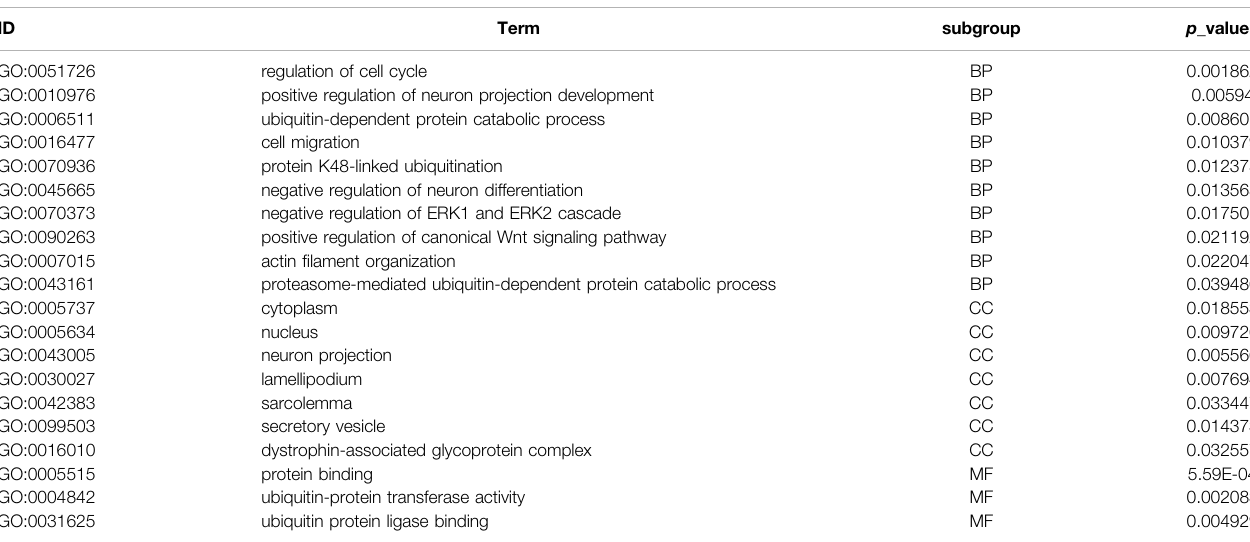
TABLE 5 | GO enrichment analysis of downregulated miRNAs.